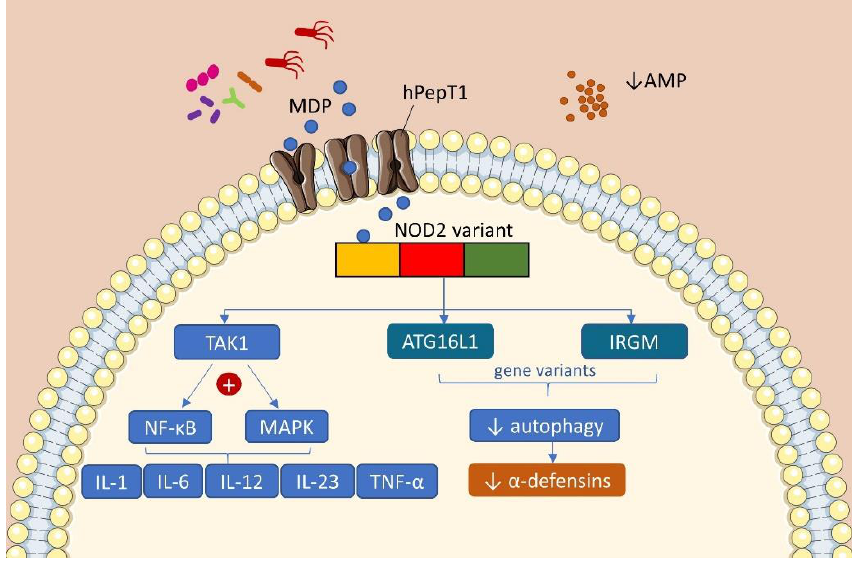
Figure 1. Consequences of the main genetic variants present in the IBD. Bacterial MDP is trans- ported by hPepT1 into the epithelial cell and is recognized by the NOD-2 receptor variant. This interaction activates the kinase TAK1 and its downstream effectors NF-kB and MAPK, leading to the production of pro-inflammatory cytokines. NOD-2 receptor also interacts with genes related to autophagy ATG16L1 and IRGM, reducing the production of AMPs and bacterial killing. In IBD, these mechanisms are impaired due to genetic variants and contribute to the pathogenesis of the disease. (AMP: antimicrobial peptides; ATG16L1: autophagy related 16 like 1; hPepT1: human peptide transporter 1; IRGM: immunity related GTPase M; MAPK: mitogen-activated protein ki- nase; MDP: muramyl dipeptide; NF-κB: nuclear factor kappa B; NOD2: nucleotide-binding oli- gomerization domain containing 2; TAK1: transforming growth factor beta activated kinase 1; TNF-α: tumor necrosis factor alpha).